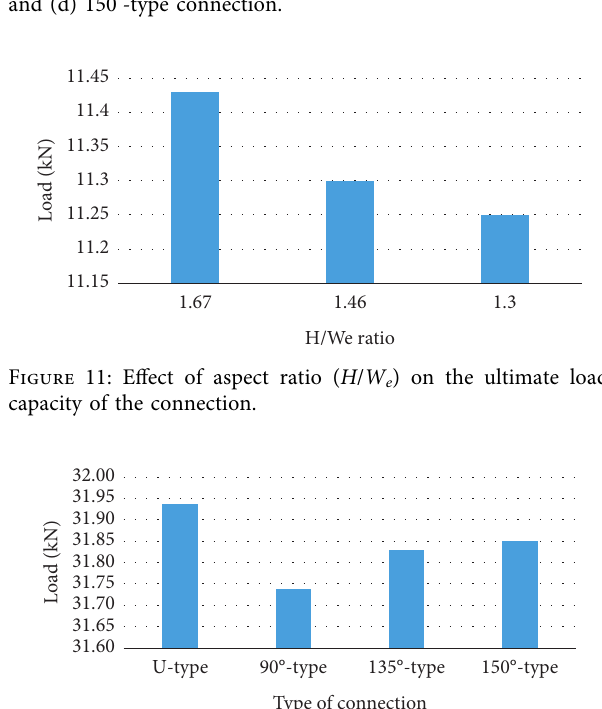
t w ) on ultimate capacity of the joint with different connections. (a) U-type, (b) 90 ° -type, (c) 135 ° -type, s /